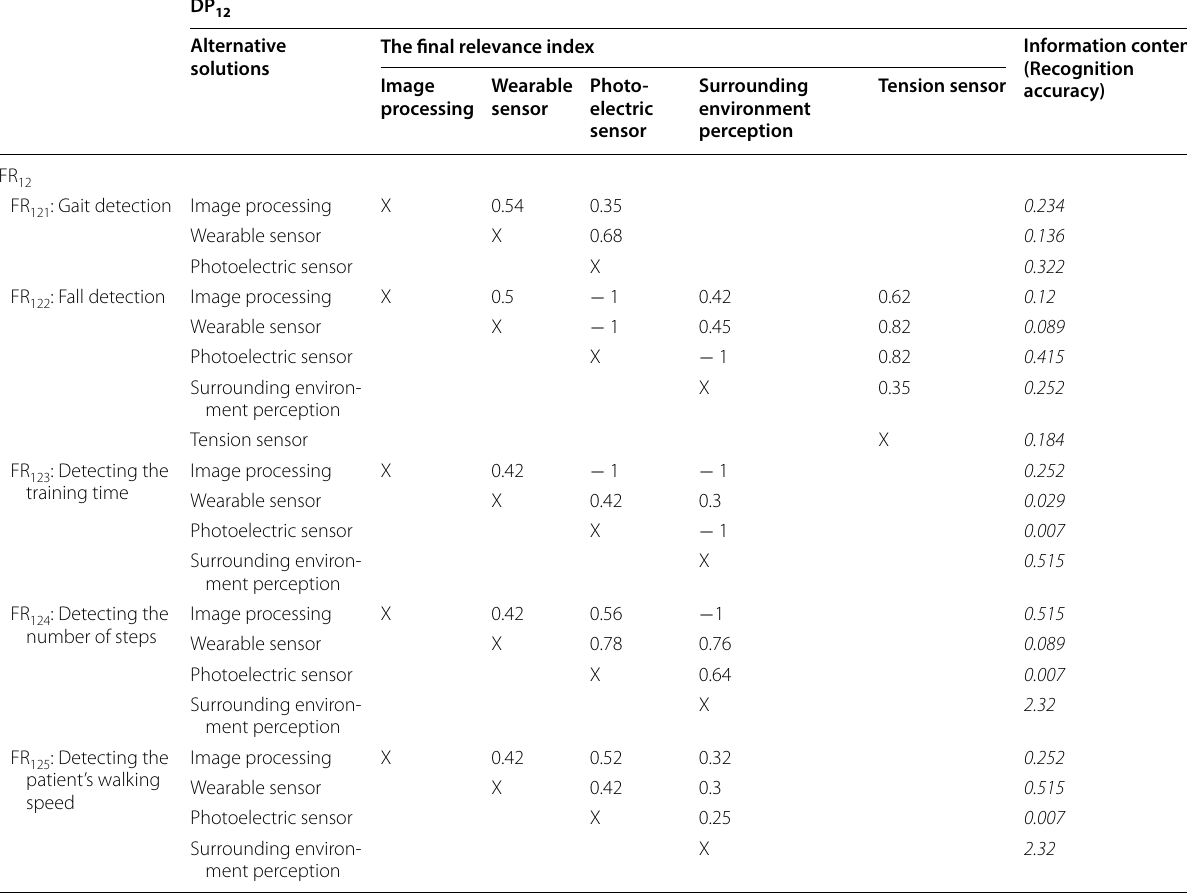
Table 1 Information content analysis based on the new hybrid axiomatic design methodology